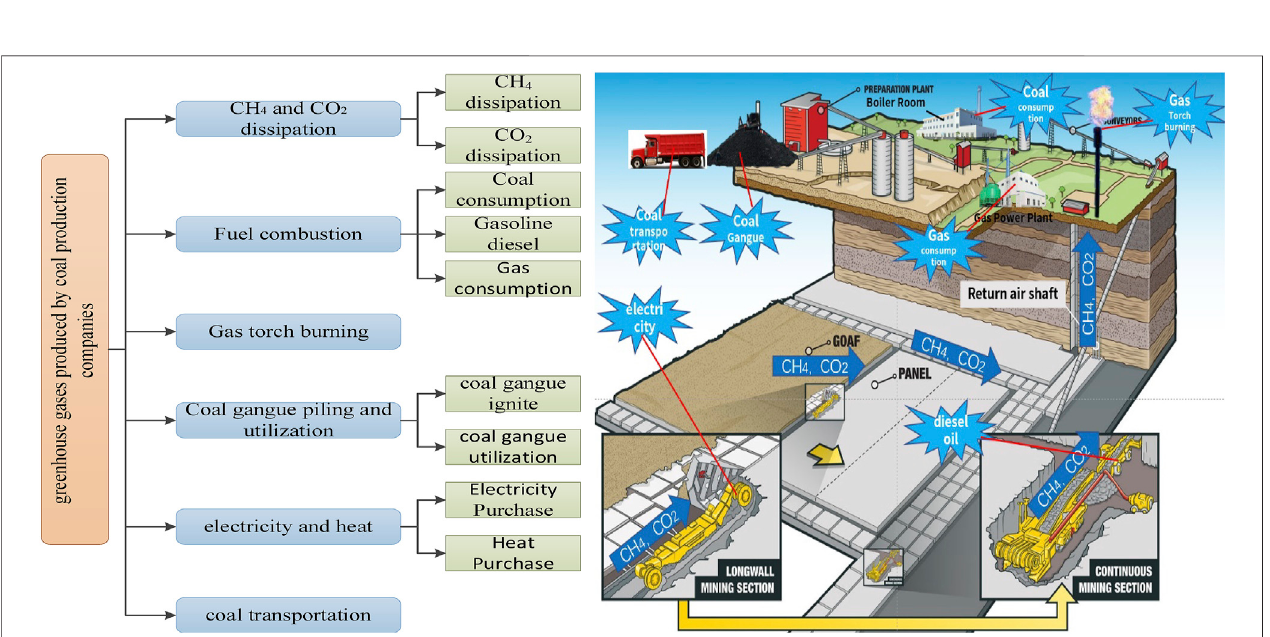
FIGURE 2 | Greenhouse gas emission sources of coal production